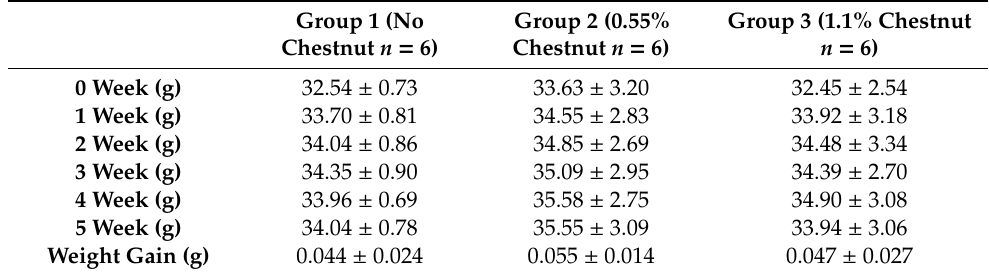
Table 1. Body weight variation (g) throughout the experimental work and weight gain (mean ± standard error).